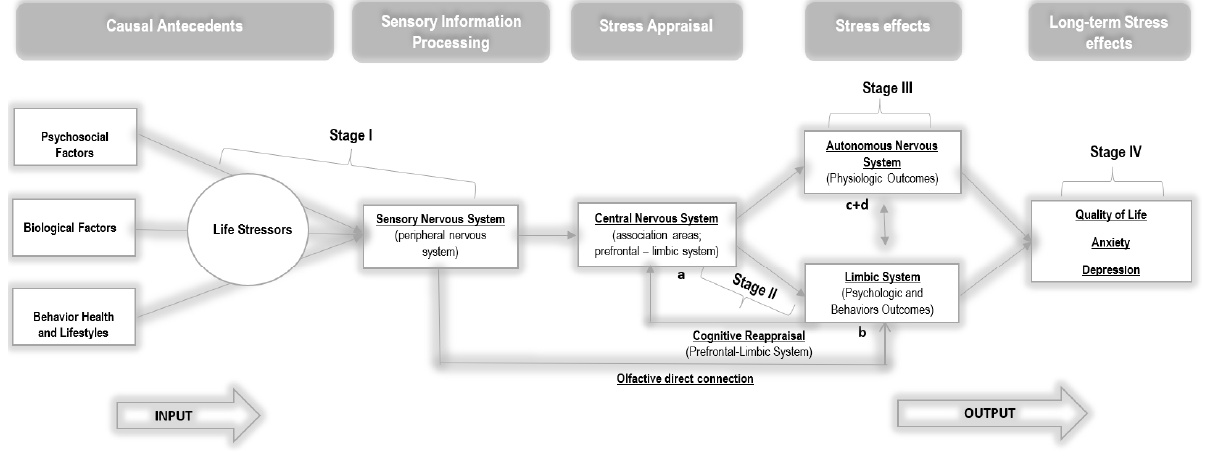
Figure 4. Neuro-psycho-physiological model of stress and coping for the control group. Adapted Transactional Model of Stress and Coping by Lazarus and Folkman [27]. ( a ) Appraisal process arising from interactions between the prefrontal cortex and amygdala, ( b ) the feeling/affect resulting from this appraisal and initiation of behavioral coping, and ( c ) autonomic and endocrine outputs from the hypothalamus, along with ( d ) downward signals to the brainstem and the spinal cord [44].